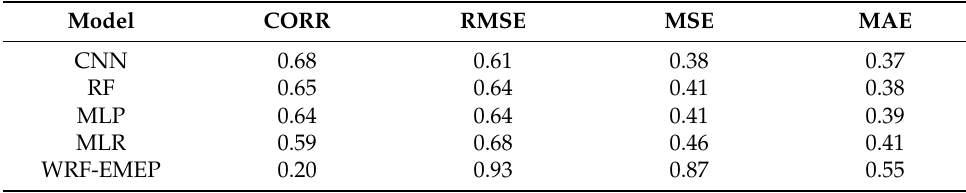
Figure 6. Comparison of model performance: ( a ) CNN, ( b ) RF, ( c ) MLP, ( d ) MLR, ( e ) WRF-EMEP. Table 1. Quantitative metrics of predictive models.